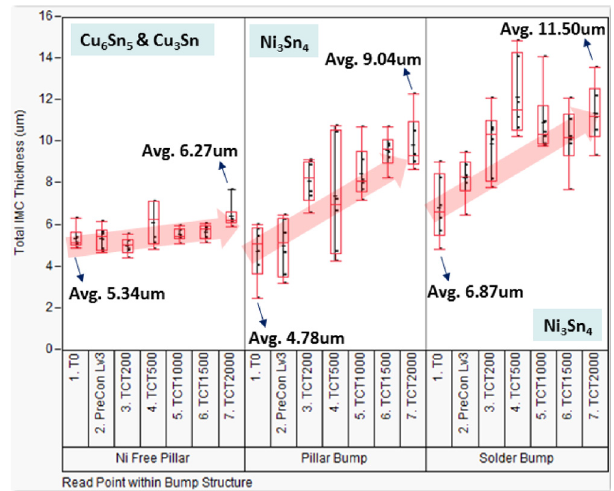
Figure 6. IMC growing thickness under TCT stress